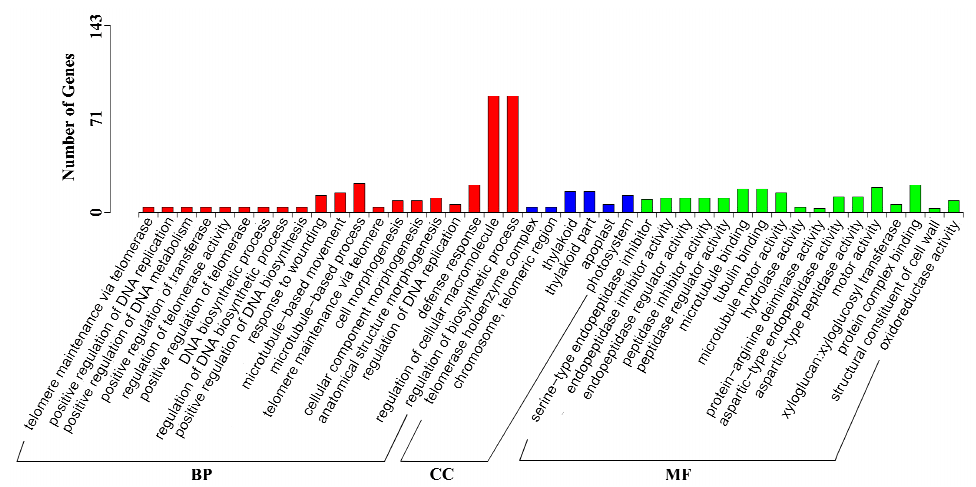
Figure 2. Gene ontology categories of DEGs after GA 3 treatment in J. curcas . BP: biological process, CC: cellular component, MF: molecular function, and p < 0.05 is the significant enrichment level.